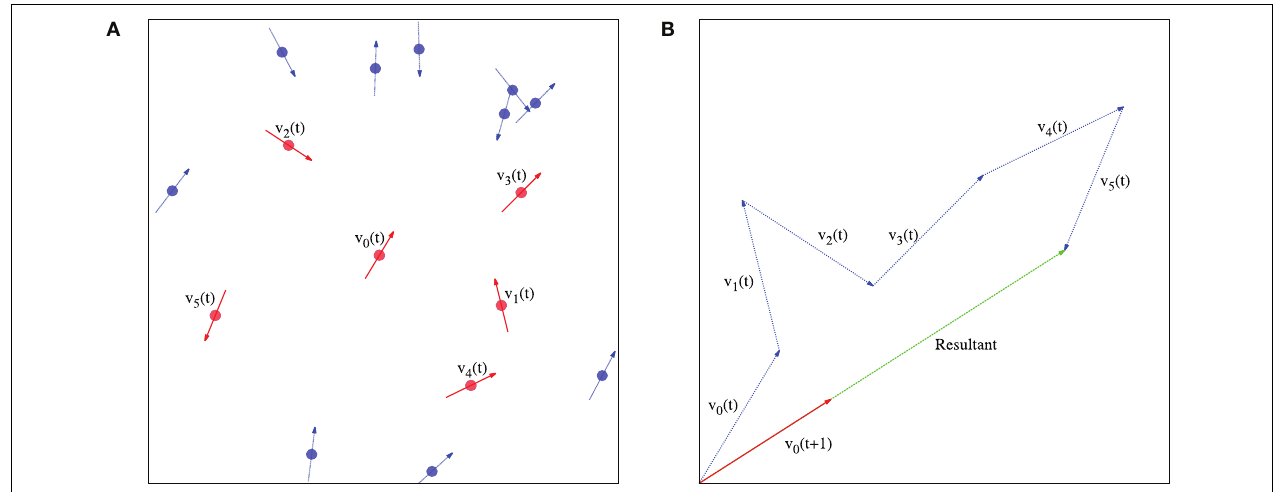
FIGURE 1 | (A) A flock of N = 16 agents with n = 5 neighbors in the interaction zone and at any arbitrary time t . The central agent is denoted by the subscript 0 and the velocity vectors of this agent and its five neighbors in